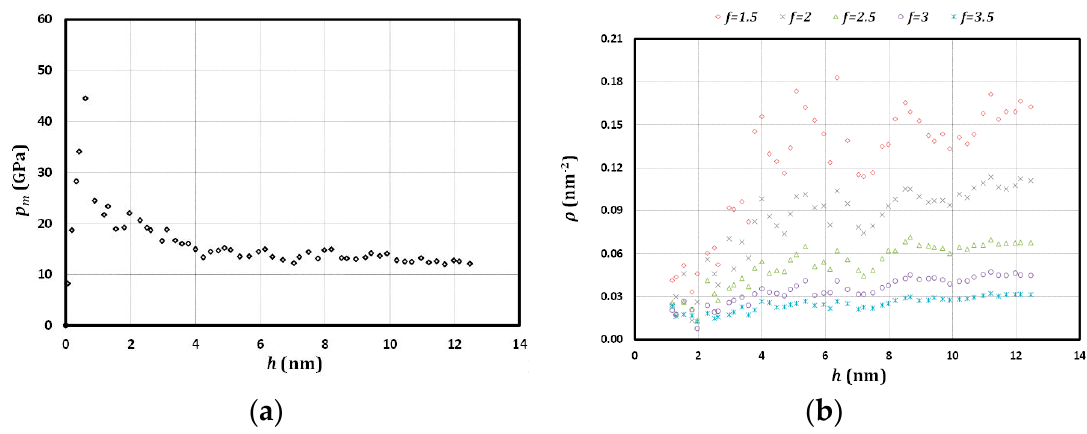
Figure 20. Large-scale atomistic simulation of a Ni thin film during nanoindentation: ( a ) variation of